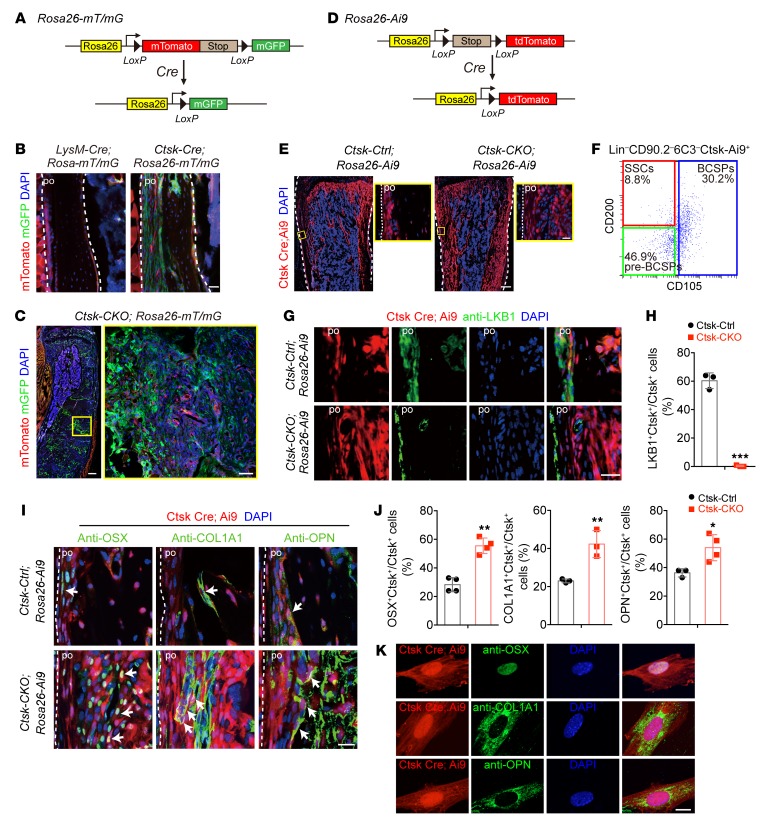
Ctsk-Cre–expressing periosteal mesenchymal stem cells are potential sources for osteogenic tumor.(A) Schematic of experiments on Rosa26-loxp-mTomato-stop-loxp-GFP (Rosa26-mT/mG) Cre reporter mice. (B) Confocal images of the tibiae of 4-week-old male LysM-Cre; Rosa26-mT/mG and Ctsk-Cre; Rosa26-m/TmG reporter mice showing that Ctsk-Cre; GFP (green), but not LysM-Cre; GFP (green) was expressed in the periosteum of cortical bone (indicated with the white arrow). Right panel: in Ctsk-CKO mice, Ctsk-positive cells at the periosteum expanded within the cortical bone. Scale bar: 50 μm. (C) Confocal images showing that the majority of the cells in the tumor region of 20-week-old male Ctsk-CKO; Rosa26-mT/mG mice are Ctsk-Cre; GFP–expressing cells (green). Scale bars: 300 μm (left); 50 μm (right). (D) Schematic of experiments on Rosa26-loxp-stop-loxp-tdTomato (Rosa26-Ai9) Cre reporter mice. (E) Images of 4-week-old male Ctsk-Ctrl; Rosa26-Ai9 and Ctsk-CKO; Rosa26-Ai9 tibiae showing expansion of Ctsk-Cre–expressing cells (red) in Ctsk-CKO mice. Scale bars: 300 μm (left): 20 μm (right). (F) Flow cytometry of cells from periosteum of 4-week-old male Ctsk-Ctrl; Rosa-Ai9 mice to identify expression of SSC markers CD105 and CD200 in Lin–CD90.2–6C3–Ctsk-Ai9+ cells. (G and H) Immunostaining of LKB1 showing that LKB1 (green) was conditionally deleted in Ctsk+ periosteal cells (red) from Ctsk-CKO; Rosa-Ai9 mice, but not in Ctsk-Ai9 cells of Ctsk-Ctrl; Rosa-Ai9 mice. Scale bar: 20 μm. (I and J) Immunostaining showing Ctsk-Cre–positive cells (red) in the cortical bone display osteoblast markers OSX (green), COL1A1 (green), and OPN (green) in the tibiae of 4-week-old male Ctsk-Ctrl; Rosa26-Ai9 and Ctsk-CKO; Rosa26-Ai9 mice (white arrow). Scale bar: 20 μm. (K) Ctsk-Ai9 cells isolated from the cortical bone of tibiae from Ctsk-Cre; Rosa26-Ai9 mice showed expression of osteoblastic markers OSX (green), COL1A1 (green), and OPN (green). Scale bar: 10 μm. Data are represented as mean ± SEM. *P < 0.05; **P < 0.01; ***P < 0.001, unpaired Student’s t test.